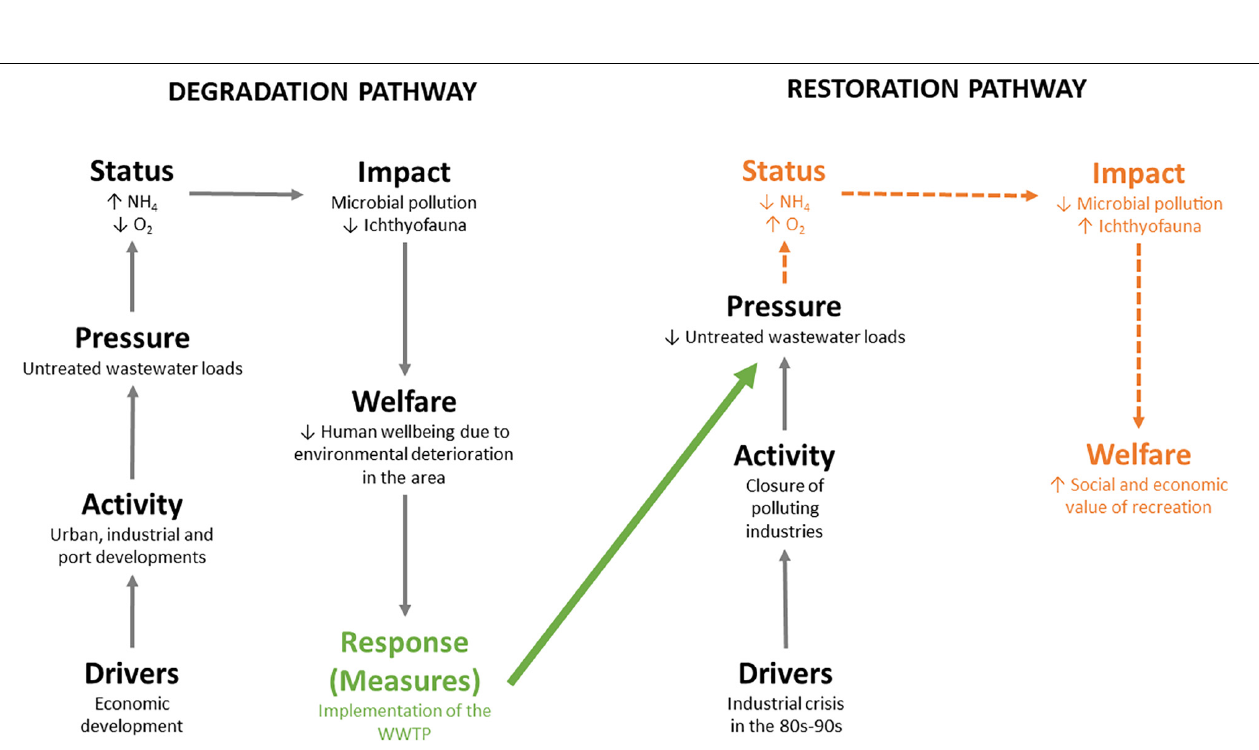
FIGURE 4 | Degradation and restoration pathways in the Nerbioi estuary, under the DAPSI(W)R(M) framework. Green: measures adopted and link/effect arrow. Black: information obtained from the literature; Orange: the part confirmed in recent publications by the authors (Pouso et al., 2018c,a,b, 2019b).